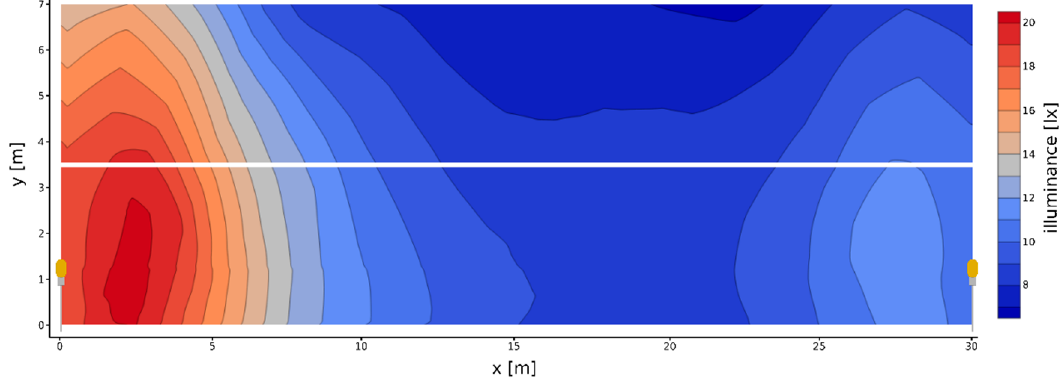
Figure 8. False color view for the illuminance [lux] of the two-lane road between Lamp 6 and Lamp 7 of the system.